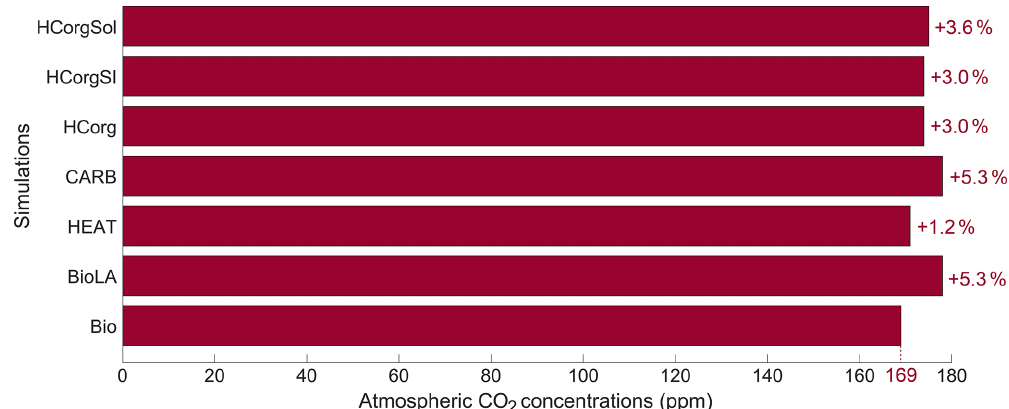
Figure 4. Atmospheric CO 2 concentrations (ppm) for the different simulations. The percentages represent the relative changes compared to the reference simulation